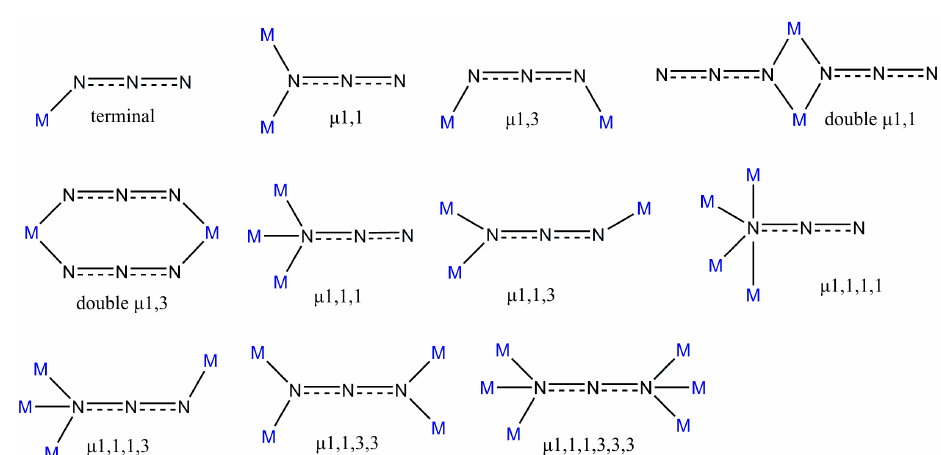
Figure 1. Structure of the PMT ligand.